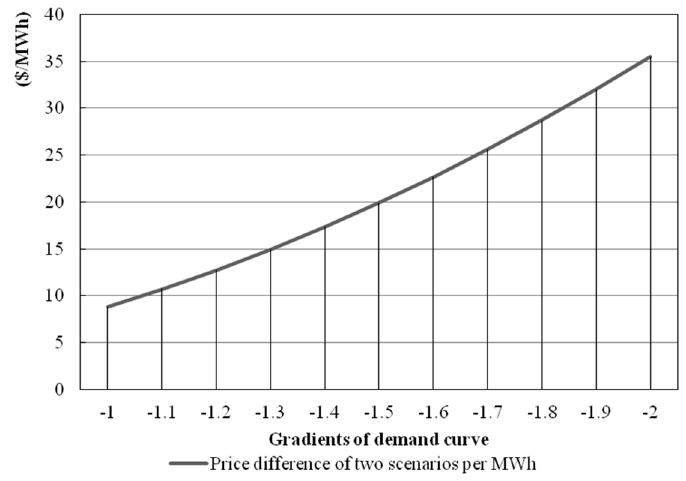
Figure 6. The assigned demand resource per